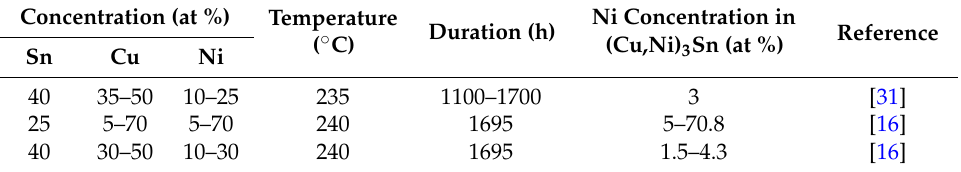
Table 3. Effects of Concentration and Heating Parameters on Ni concentration in (Cu,Ni) 3 Sn IMC. Concentration (at %) Temperature